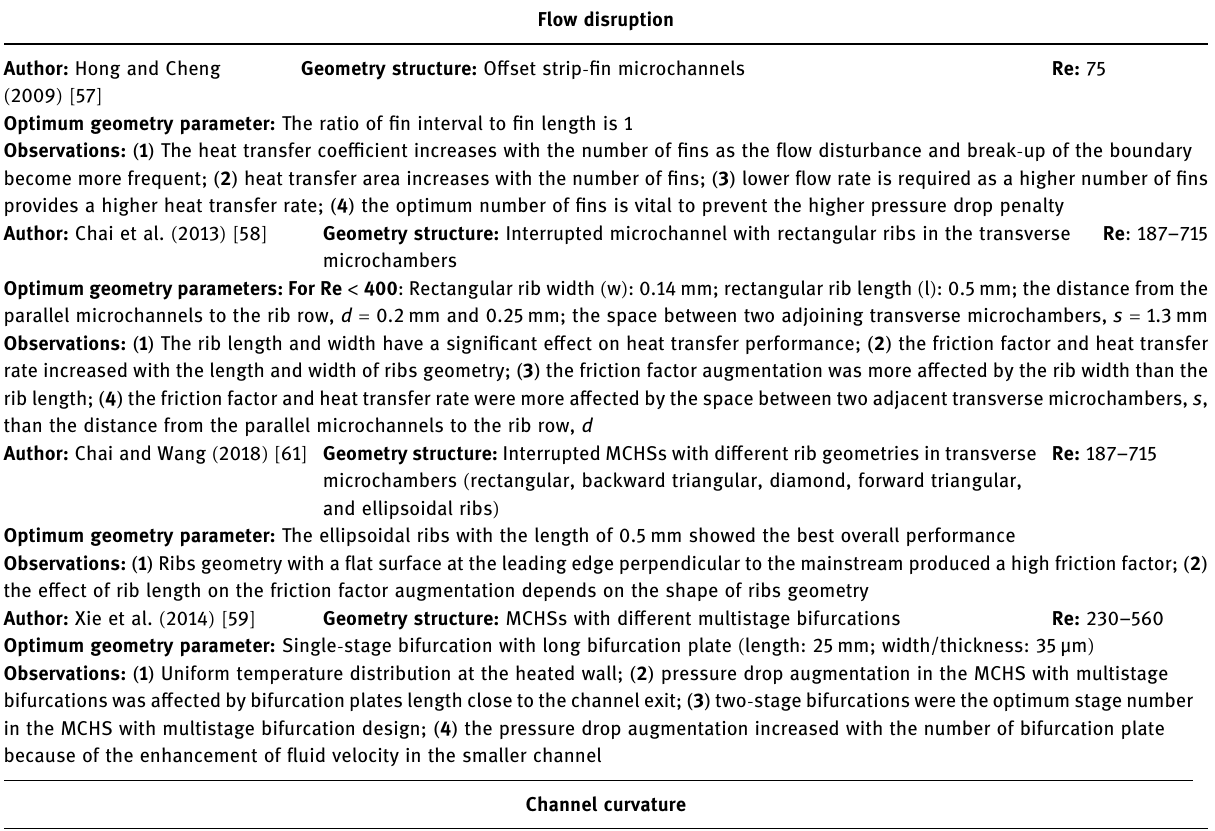
Table 1: Performance of MCHS with single/individual passive method